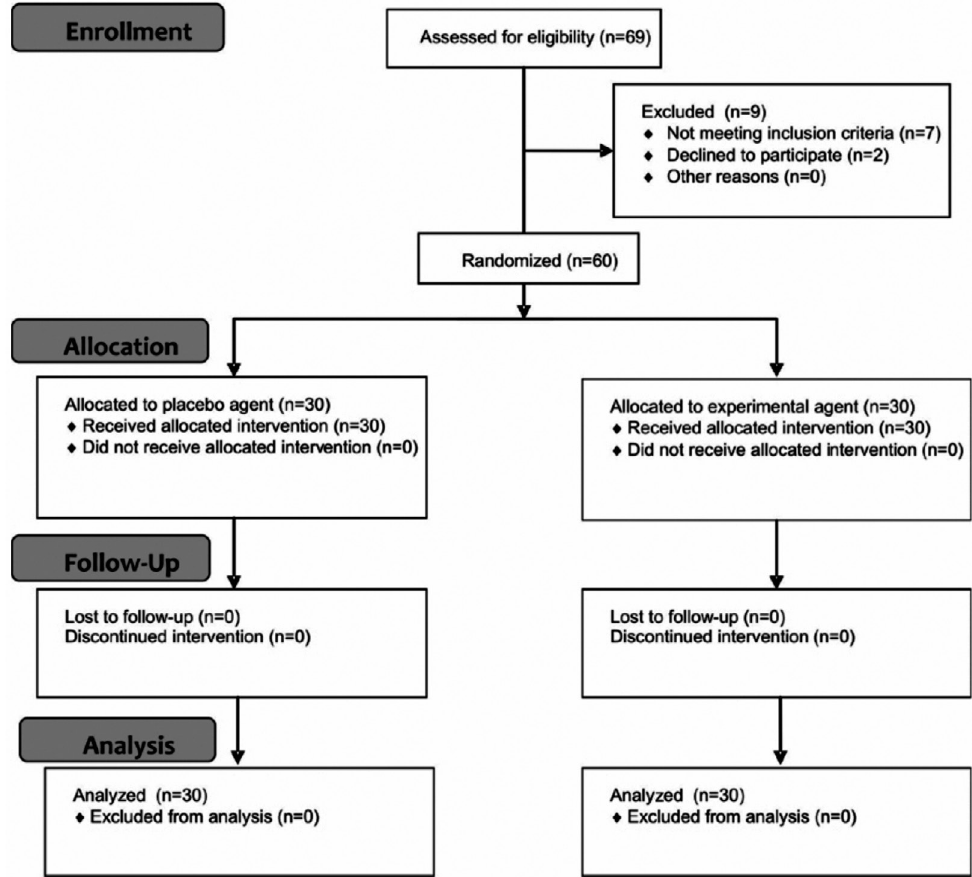
Figure 2- Flow chart diagram detaching the enrollment, allocation, follow-up, and analysis during the study (CONSORT